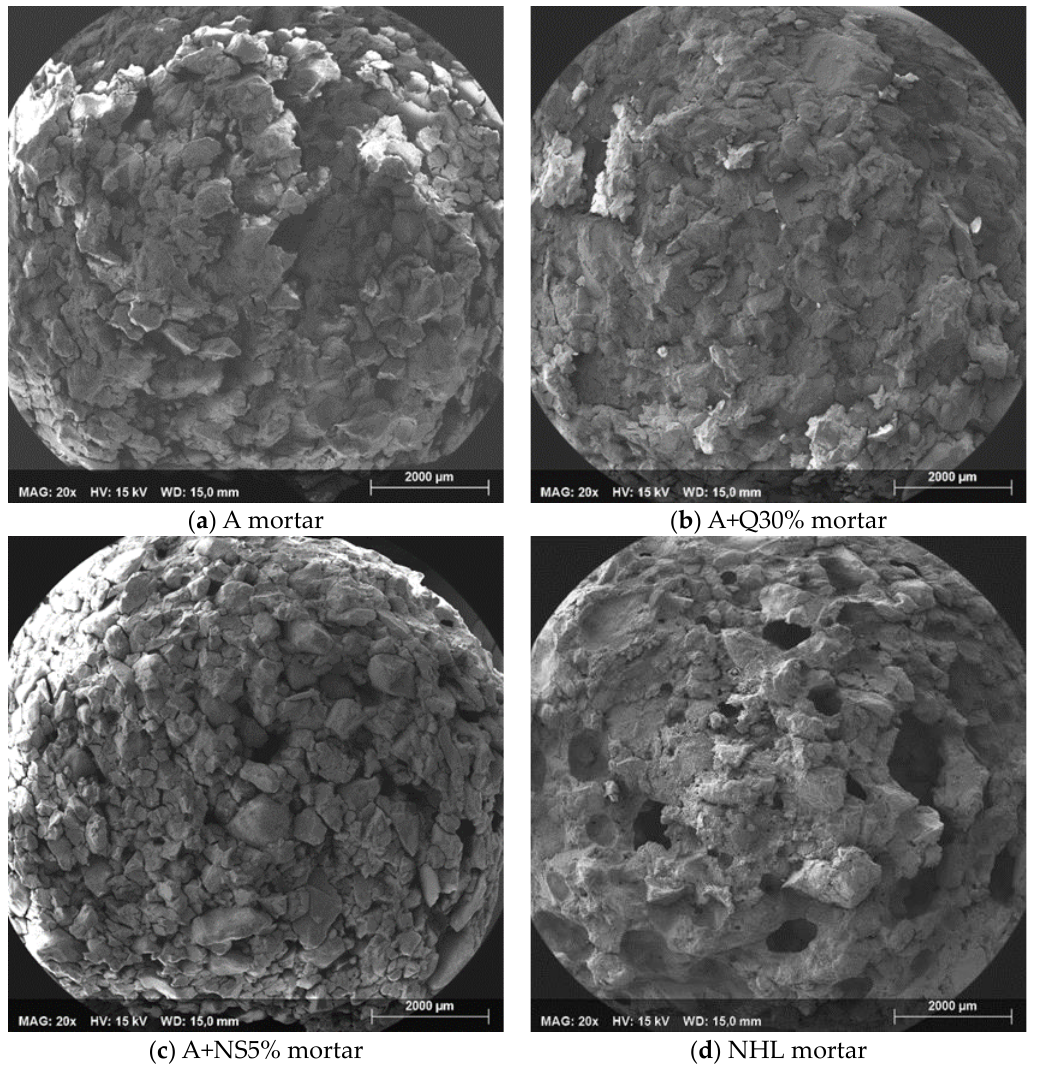
Figure 4. SEM images of the mortars’ microstructure at low magnification, with a working distance (WD) of 15.0 mm. It is possible to observe the compact microstructure of the A (slaked air lime) mortar ( a ) and A+Q30% (slaked air lime with 30% of quicklime) mortar ( b ); the general microcracking on the A+NS5% (slaked air lime with addition of 5% of nanosilica) mortar is shown ( c ); as well as the heterogeneous microstructure of the NHL (natural hydraulic lime) mortar with few unconnected sub-rounded macropores ( d ).